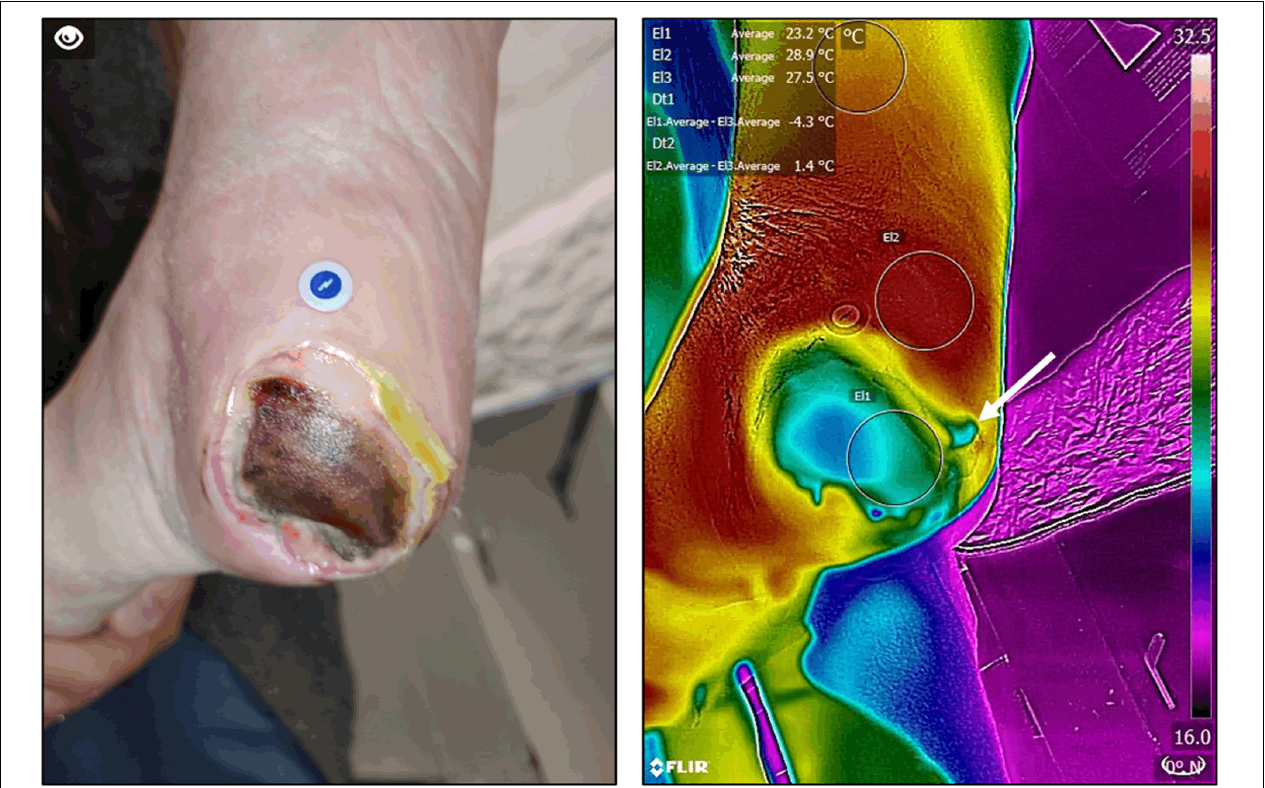
FIGURE 6 | Deep tissue injury thermographic assessment. Infrared thermography was used to assess the severity of deep tissue injury in a patient with a healing pressure ulcer. Thermography confirmed an extensive area of devitalized tissue underneath the wound’s eschar. In addition, it also allowed the identification of significant peri-wound inflammation and more devitalized tissue (arrow) which was not apparent at clinical inspection alone. Images, courtesy of JR-G, were acquired using the Skin and Wound mobile app (Swift Medical Inc., Toronto, ON, Canada) paired to a FLIR One Pro mobile